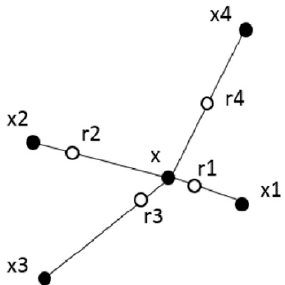
Figure 2. New data synthesized by SMOTE.